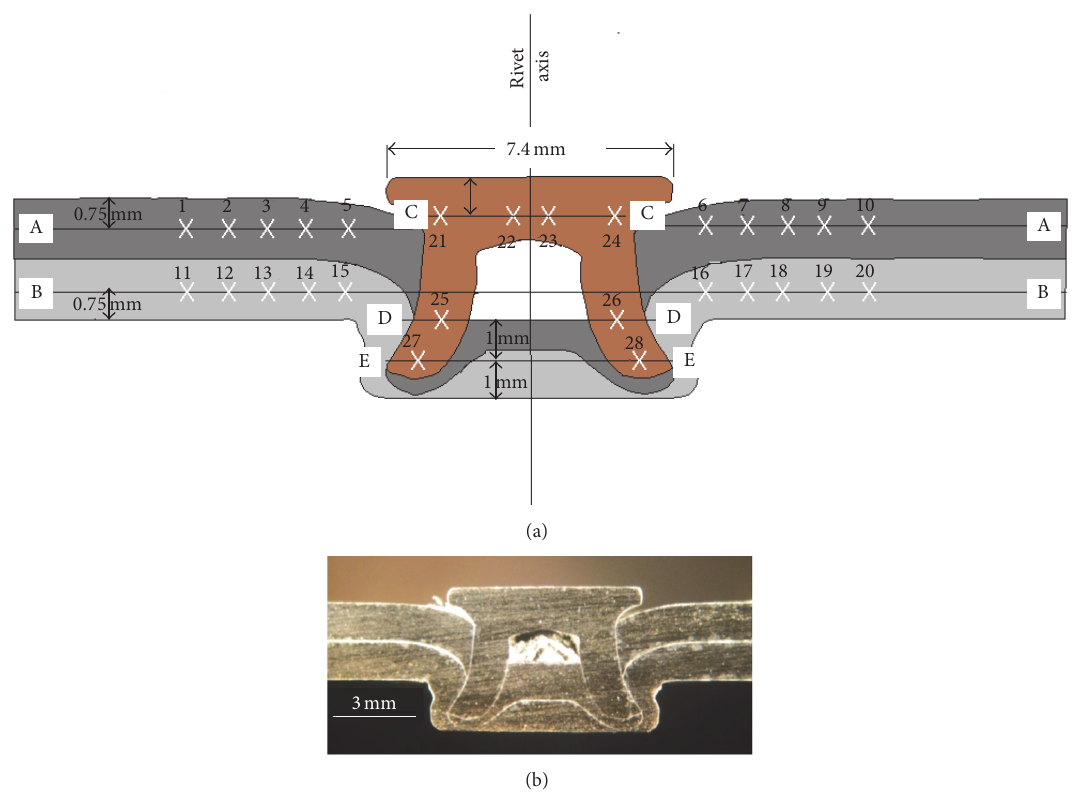
Figure 4: Joint I of Table 1: (a) residual stress measurement locations; (b) micrographic cross-section which was sectioned after conducting neutron diffraction